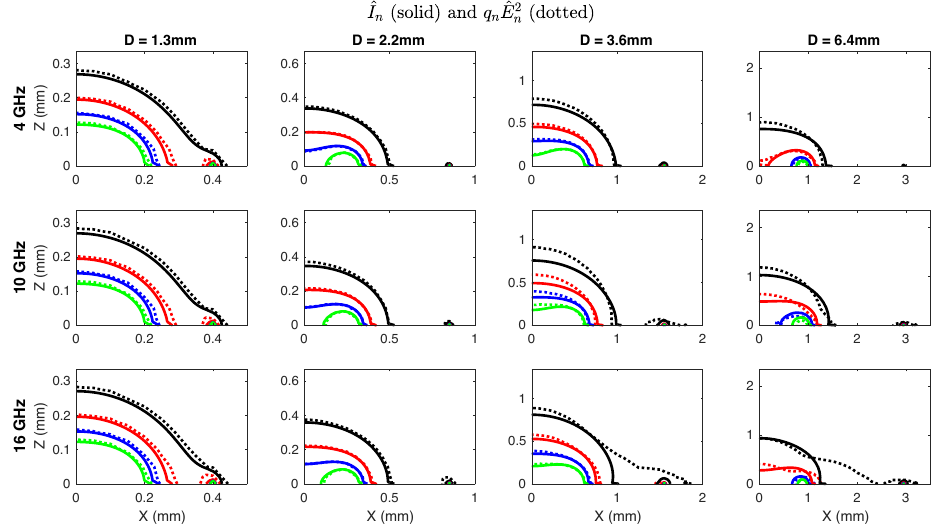
Figure 5. Overlay of ˆ I n (dotted lines) and q n ˆ E 2 (solid lines) at levels of 0.5 (black), 1 (red), 2 (blue) and 3.5 (green) to illustrate curve fitting. Overall fit was very good at lower frequencies and with smaller probes. More observable discrepancies in fit can be seen with 3.6 and 6.4mm probes at frequencies over